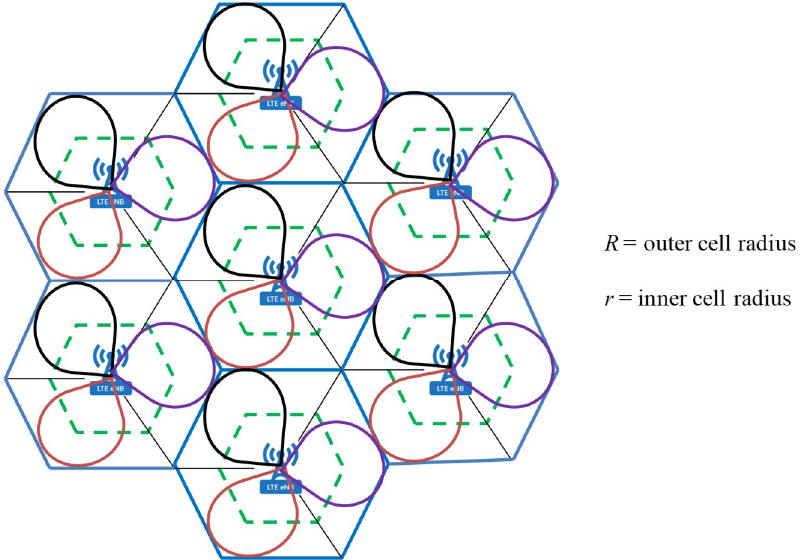
Figure 1. The multicell cellular network with cell sectorization using three-120° directional antennas.